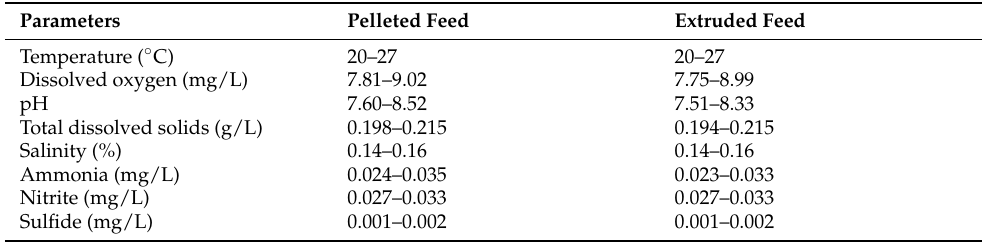
Table 2. Water quality